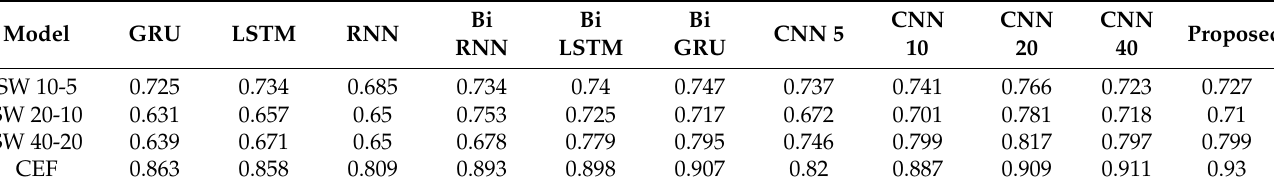
Table 4. Results of comparison with the SW